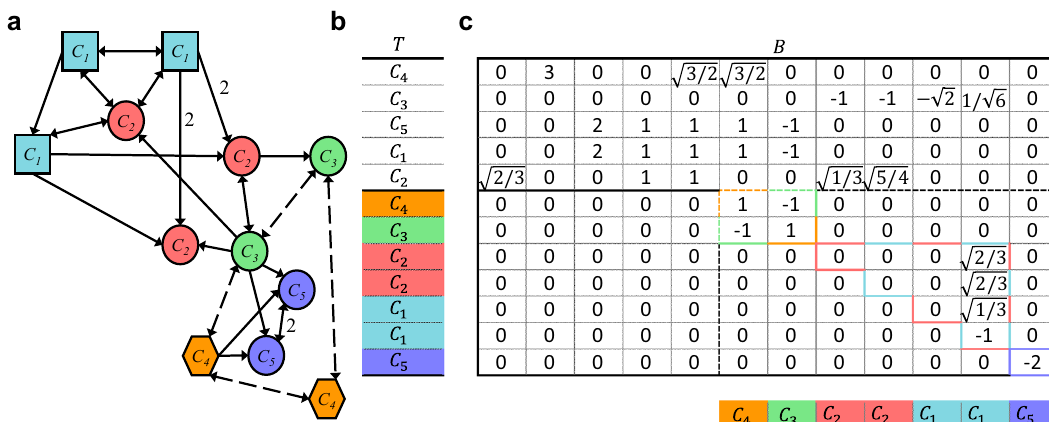
δ : it is apparent that Δ φ i 1 vs. i 1 grows